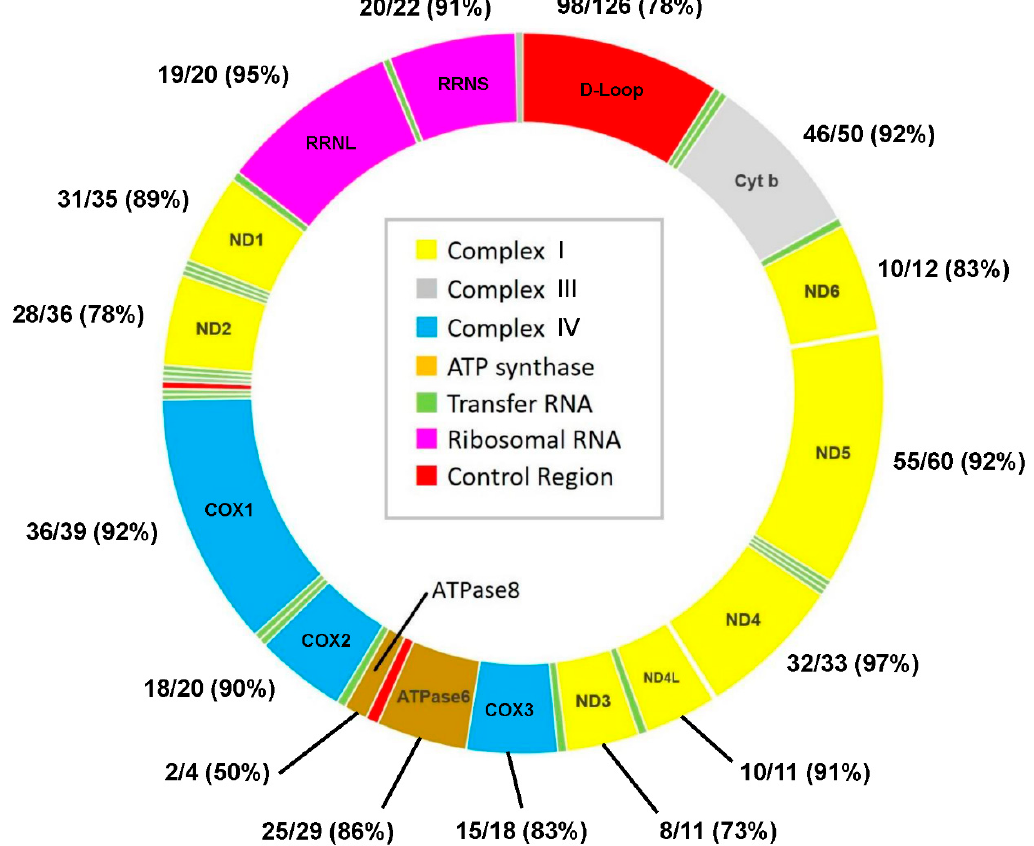
Figure 1. The map of human mitochondrial DNA, and number and percentage of low-frequency polymorphisms among all polymorphisms in each region. (There were 28 polymorphisms in the tRNA region, and all were low-frequency polymorphisms. Three of the four polymorphisms in the intron region were low-frequency polymorphisms.)